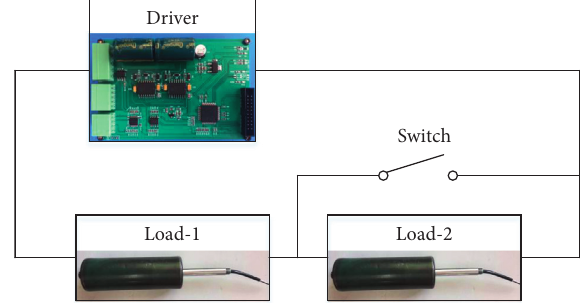
Figure 14: Load changing experimental diagram.